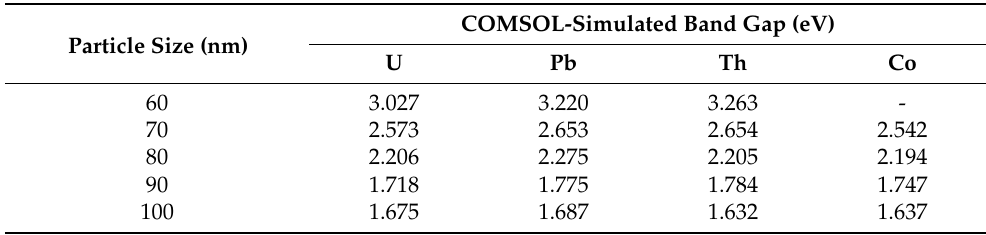
Table 2. COMSOL-simulated band gap values of d(ln( α h ν ))/d(h ν ) versus h ν for the U, Pb, Co, and Th nanoparticles.